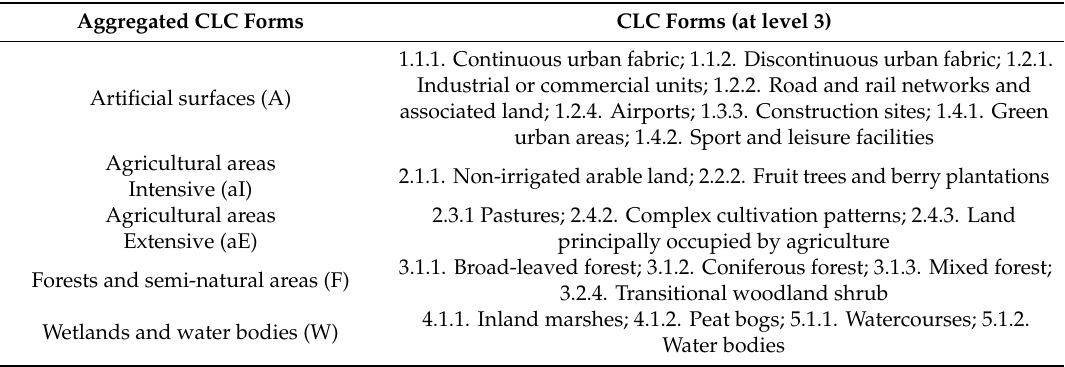
Table 2. Aggregated CLC classes used in the